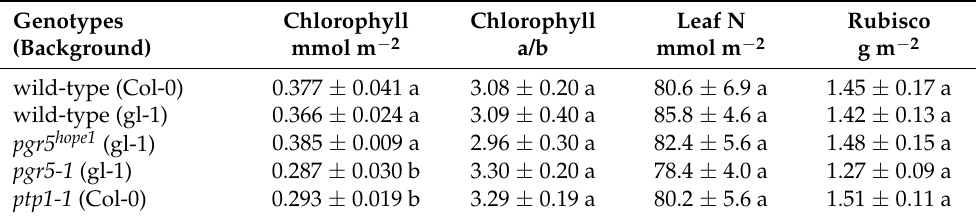
Figure 3. The effect of PTP1 mutation on the growth of PGRL1 deficient mutants. ( A–C ) were the data of plants grown under constant light conditions (250 μ mol-photons m − 2 s − 1 ). A is a picture of representative plants grown for 28 days. The parentheses indicate the background genotypes of each mutant. The scale bar is 7 cm. ( B ) shows the fresh weight (white bars) and SPAD values (black bars). Data are means ± sd. ( n = 4). ( C) shows the maximum quantum yield in PSII ( Fv/Fm ; white bars) and the maximum amount of photo-oxidizable PSI ( Pm ; black bars). Data are means ± sd. ( n = 4) Pm is a relative value with the value wild-type Col-0 being 1. In ( B , C ), the different alphabets indicate significant differences analyzed by Tukey’s HSD test. ( p < 0.05). Table 1. The chlorophyll, leaf total N and Rubisco amount in pgr5-1 , pgr5 hope1 and ptp1-1 . After photosynthesis measurement (Figure 5), leaves were used for the determination of leaf components. Dara are means ± sd. ( n = 4–5) Different alphabets beside the numbers indicate the significant difference analyzed by Tukey’s HSD test ( p <